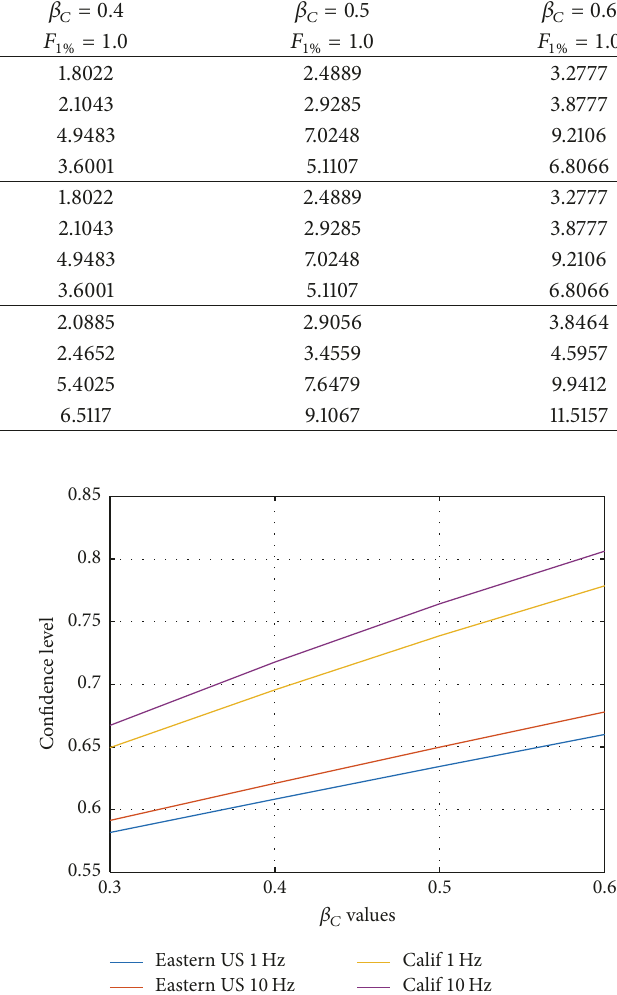
Table 5: Error results for both the first and second criteria of ASCE/SEI 43-05 for representative hazard curves. SDC